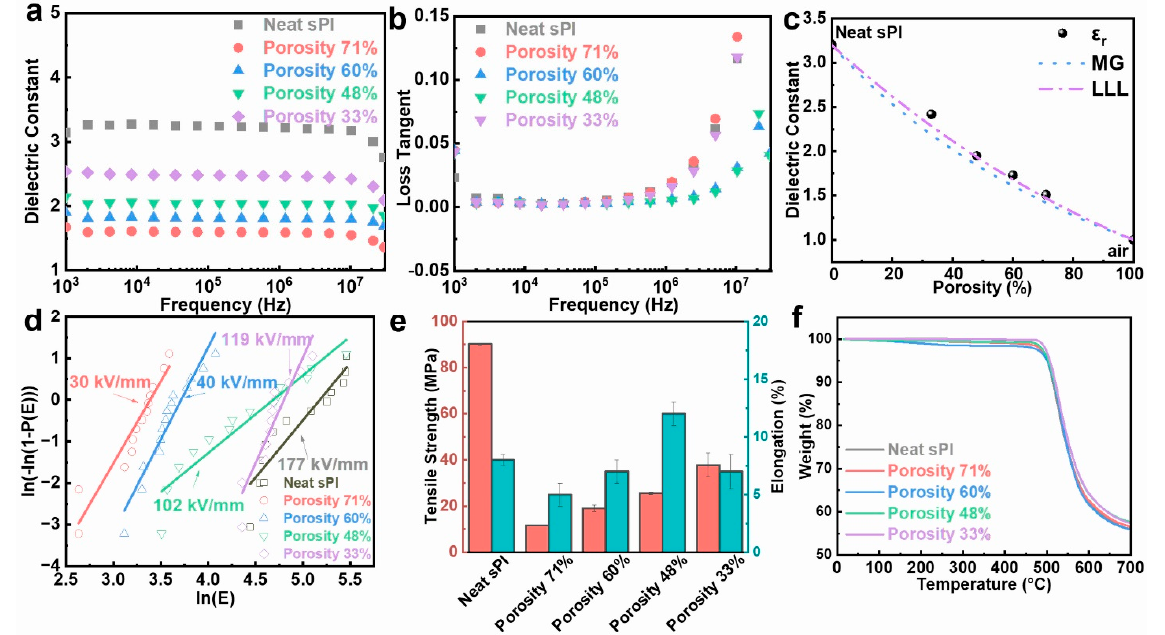
Figure 4. Performance of porous polyimide films with different porosities: ( a ) dielectric constant and ( b ) loss tangent; ( c ) dielectric constant at 10 5 Hz vs. porosity of the porous sPI films. The measured data are compared with predictions from two models of composite: Maxwell–Garnett (dotted line), Looyenga–Landau–Lifshitz (dotted–dashed line); ( d ) electric breakdown strength; ( e ) tensile strength and elongation at break; ( f ) thermal stability.